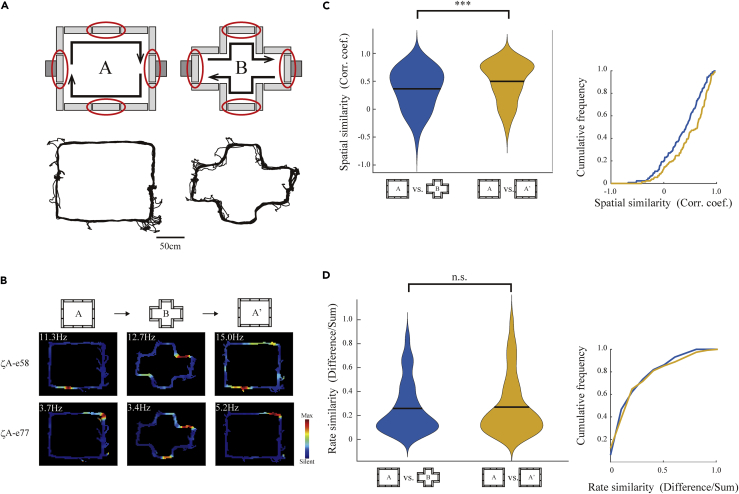
Place Field Remapping during the Maze Morphing Experiment(A) Schematics of square and cruciform mazes configured by our system (top) and the representative running trajectory of a rat (bottom). The runways enclosed by red circles were not moved during the morphing experiment.(B) Representative change of the place field of a place cell recorded from a rat (ζA) during maze morphing. The maximum firing rate is displayed at the top left corner.(C and D) Violin plots of spatial similarity as the spatial correlation of the firing rate map (C) (z = −3.98, p = 10−4) and rate similarity as firing rate difference within place fields (D) (z = −0.60, p = 0.55) between the square maze and cruciform maze, and between the first and second exposures of the square maze (left). The bar indicates the median. Surrounding each side is a rotated kernel density plot. Their cumulative frequency is graphed to the right.All were from two-tailed Wilcoxon signed-rank test. ***p < 0.001, n.s.: p > 0.05.